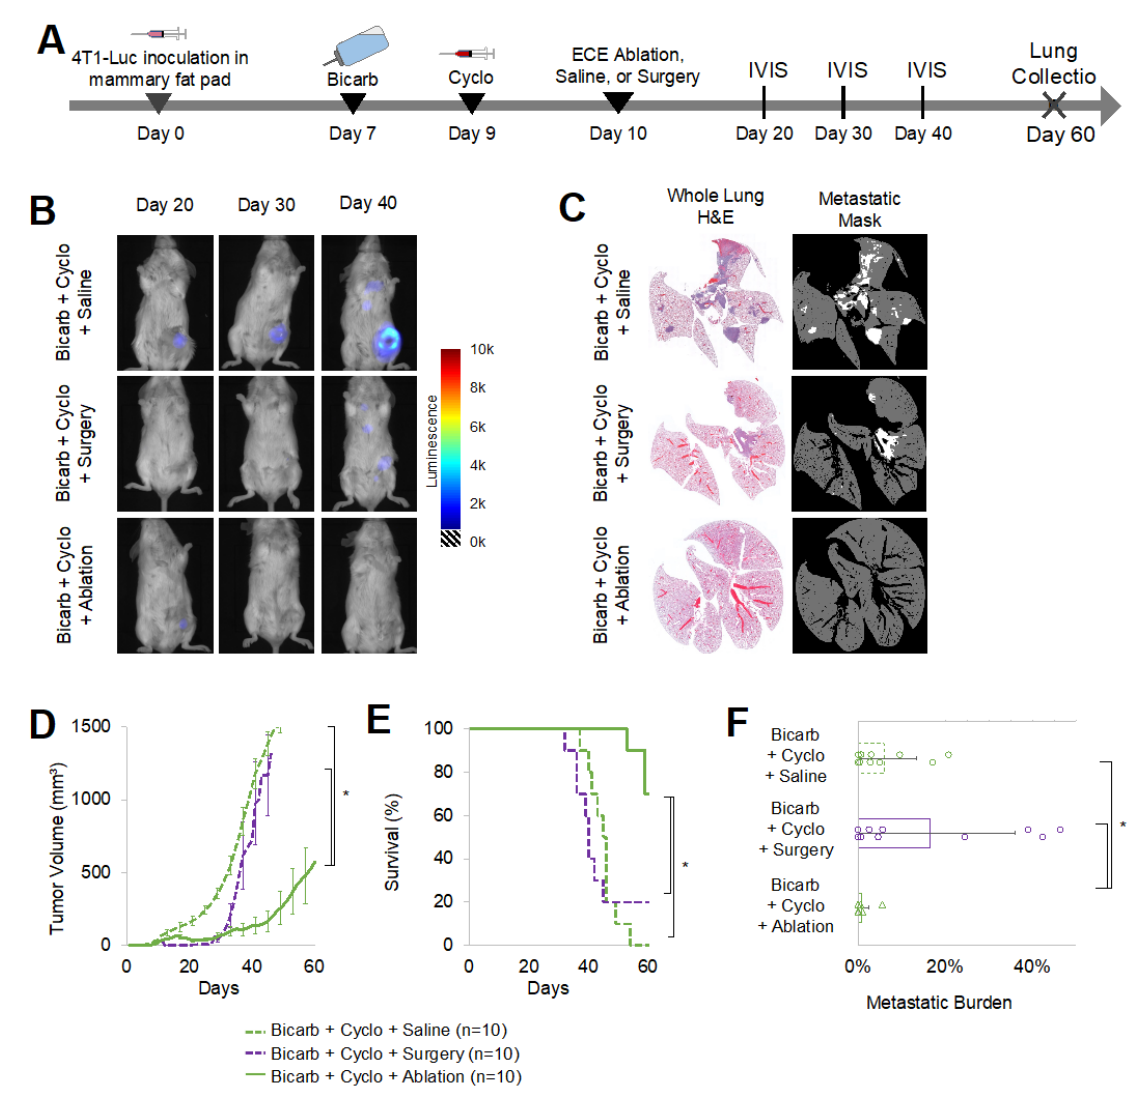
Figure 5. BiCyclA induced a more anti-metastatic response than surgery and could be integrated with surgical excision to control primary tumor growth. ( A ) Treatment timeline of ECE ablation, saline injection, and surgical excision in 4T1-Luc tumors. ( B ) Representative IVIS imaging of mice with 4T1-Luc tumors over time. ( C ) Representative whole-lung H&E and corresponding metastatic identification masks. ( D ) Average primary tumor growth for each treatment group. ( E ) Survival for each treatment group. ( F ) Metastatic burden for each group. * p < 0.05, KS test for (D,E), Student’s T-test for (F).